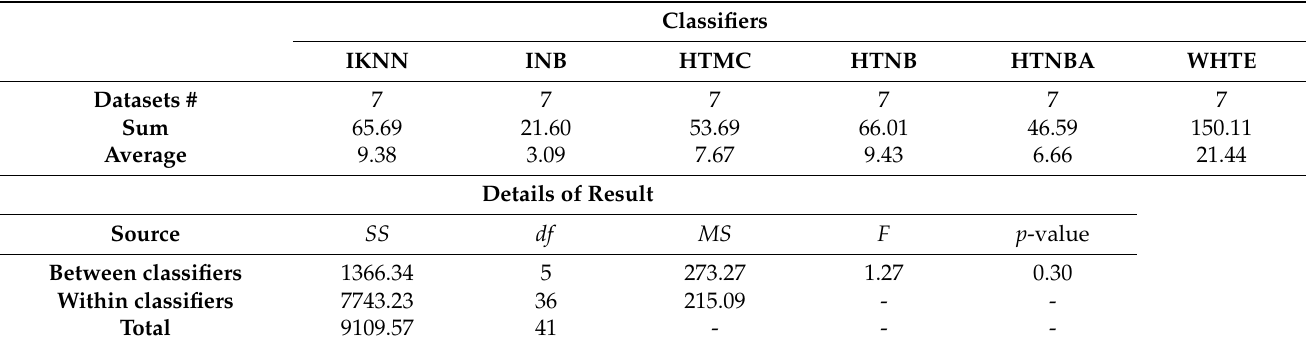
Table 5. The ANOVA test results, where computation time is the independent variable.